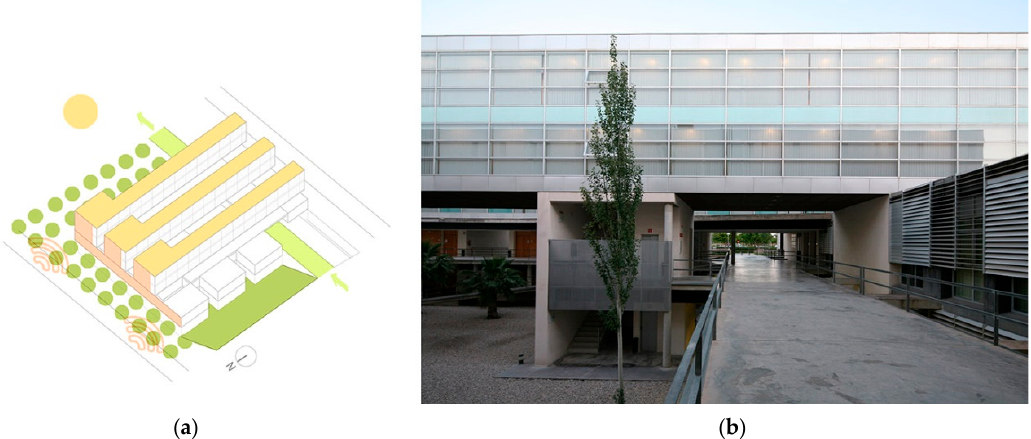
Figure 4. Sketch of adjacent area ( a ) and passage ( b ) through the HPS IV. Drawing: Carlos Pastor García. Photo: Courtesy of UA’s Technical Office.